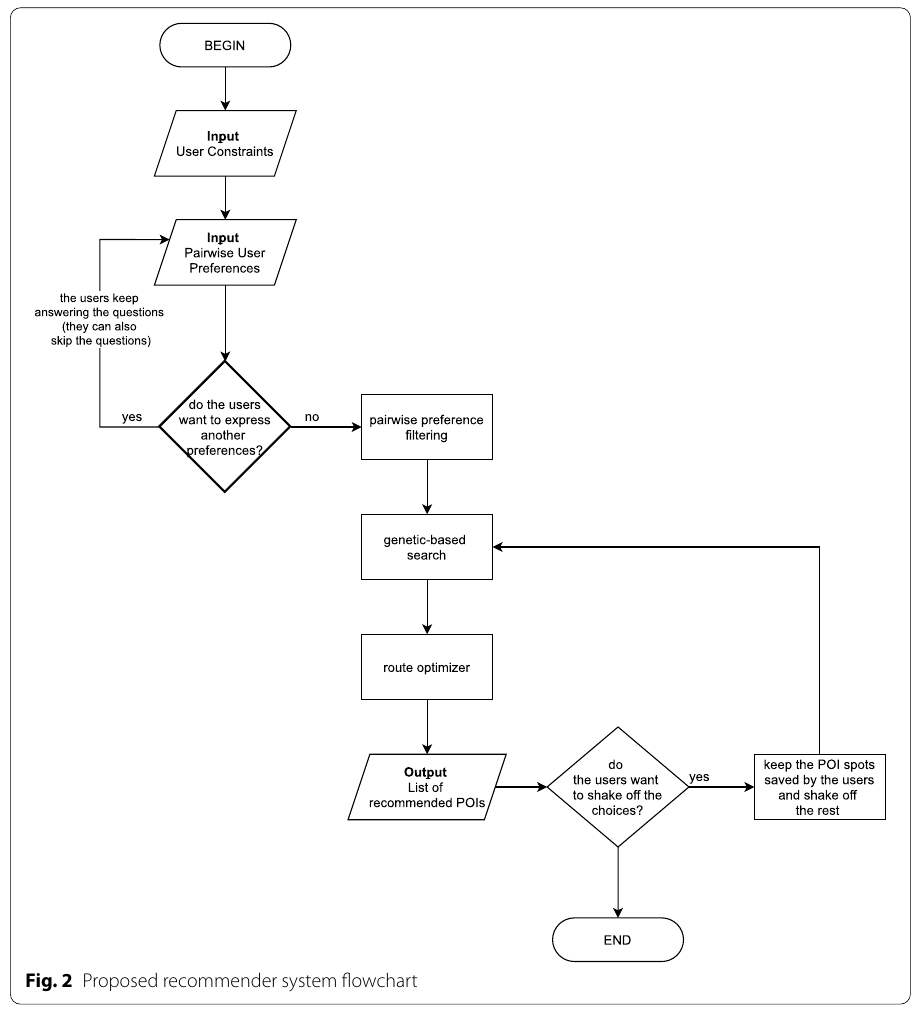
Fig. 2 Proposed recommender system flowchart